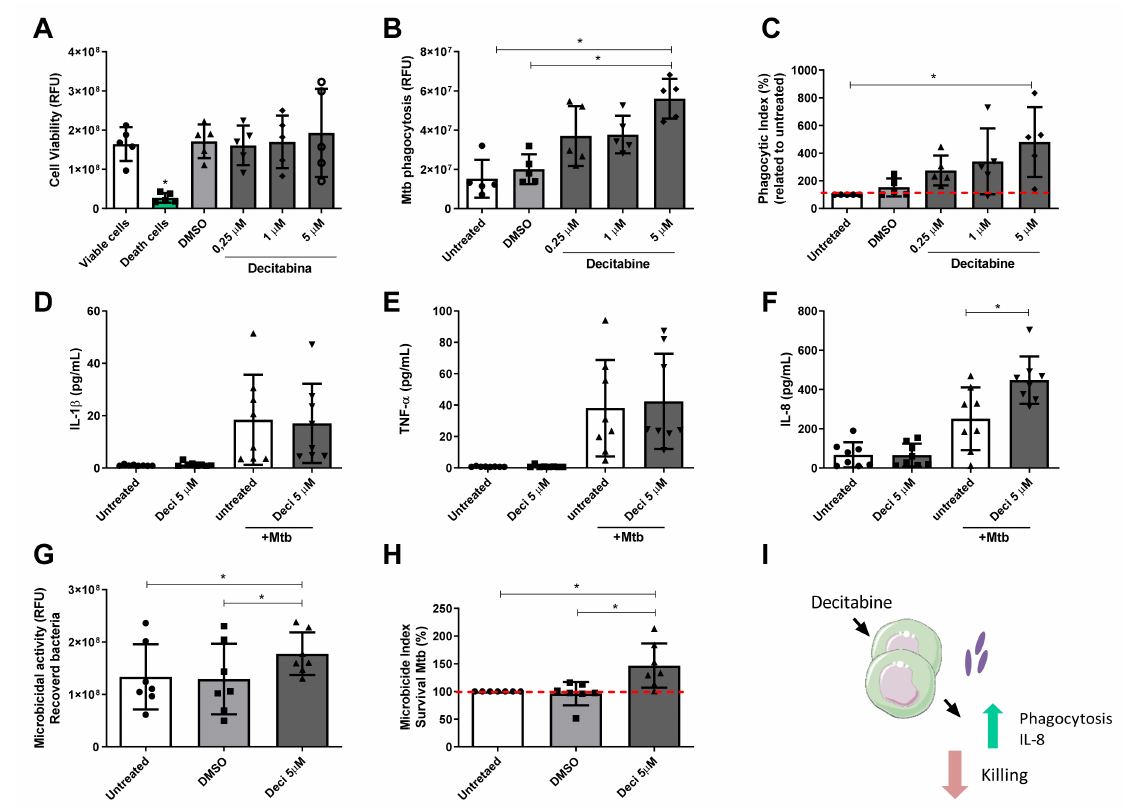
Figure 1. Decitabine treatment modulated the monocyte response to mycobacterial infection. Monocytes were isolated from healthy individuals and pretreated with decitabine (0.25–5 µ M), DMSO, or untreated for 24 h. After this period, cell viability was assessed by detecting resazurin metabolism ( A ). In addition, cells were infected with Mtb (MOI 5) for different periods. For phagocytosis analysis, cells were infected for 2 h, followed by washes with PBS, saponin lyses, and exposure to internalized bacteria. The number of phagocytized bacteria was determined indirectly by detecting resazurin metabolism, expressed in ( B ) and phagocytic index, normalized in relation to untreated cells, considered as 100% ( C ). Immune mediator release was determined after 24 h of pretreated monocyte infection with Mtb and quantified using a Magnetic Luminex Assay kit, as demonstrated in ( D ) IL-1 β , ( E ) TNF- α , and ( F ) IL-8. ( G , H ) Microbicide activity was evaluated after 24 h of infection and the number of bacteria recovered from cells was quantified indirectly by detecting resazurin metabolization, expressed in ( G ), and the killing index was determined by normalization of RFU quantitation, in relation to untreated cells, considered as 100% ( H ). Data are expressed as mean ± standard deviation and analyzed by paired ANOVA, followed by a Tukey’s test. Phagocytosis and killing index were analyzed by a Friedman test (non-parametric), followed by a Dunn’s test. All the analyses consider * p < 0.05 as statistically significant ( I ) A schematic summarizing the effects of decitabine on monocyte function during Mtb